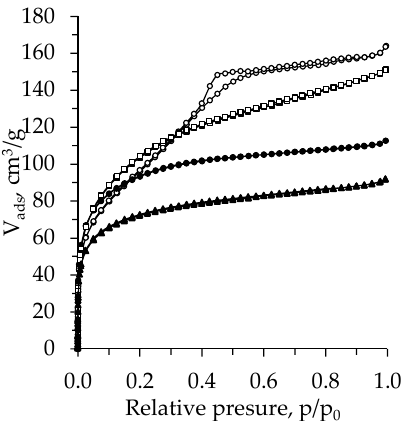
Figure 6. Isotherms for subcritical dried TiO 2 aerogel synthesized using precursor TBOT and addi- tional nH exchange (unaged ( ▲ –without exchange, –nH) and aged ( –without exchange, – nH)).